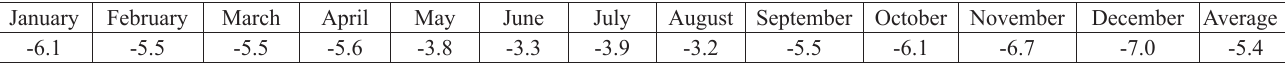
Table 2. Oxygen isotopic values ( δ 18 O V-SMOW ‰) for water at San Gerardo de Limoncito at the present day. Data from Bowen and Wilkinson 2002; Bowen and Revenaugh 2003; Bowen et al. 2005; Bowen